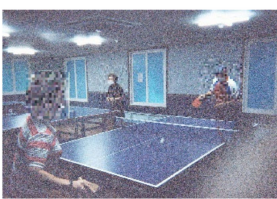
Figure 8. Table tennis court.